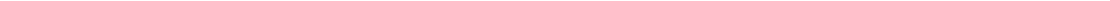
Fig. 4. SEM micrographs of selected specimens of Vikisphaera kundana gen. et sp. nov., all from the Kunda Regional Stage, lower Darriwilian. A – J , L , M from the type locality, Viki core, depth 360.9–361.1 m, sample OM8-4; K from the File Haidar core, Gotland, Sweden, depth 341.61–341.70 m. A , B , three-dimensionally preserved whole specimens; C – G , broken or deformed whole specimens; H – M , specimens split into halves, showing variable thickness of the shell wall. H , K , M split along the groove, L split into half- sphere perpendicular to the equatorial groove, the location of the groove in cross-section is indicated by arrows. Specimen numbers: A , GIT 742-1, holotype; B , GIT 742-2; C , GIT 742-3; D , GIT 742-4; E , GIT 742-5; F , GIT 742-6; G , GIT 742-7; H , GIT 742-8; I , GIT 742-9; J , GIT 742-10; K , GIT 742-11; L , GIT 742-12; M , GIT 742-13. The scale bar corresponds to 50 μ m, except in J , where it corresponds to 10 μ m.